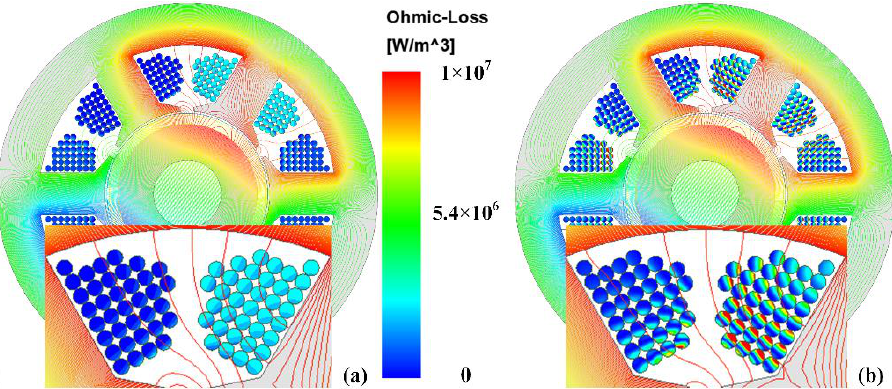
Figure 6. Distribution of copper loss density in the stator winding according to the current waveform: ( a ) sinusoidal and ( b ) PWM current.